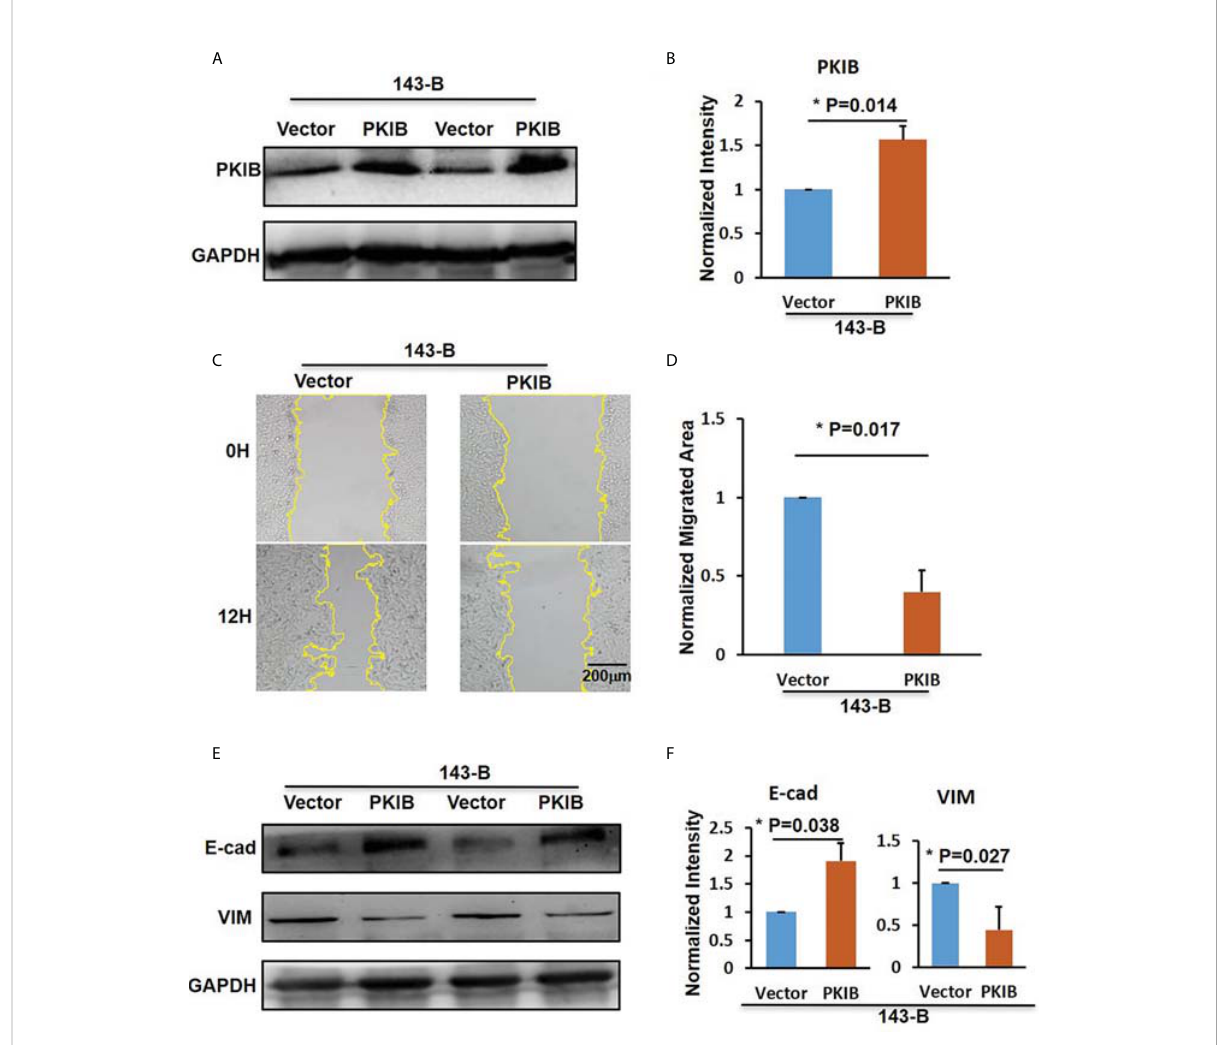
FIGURE 4 PKIB inhibit the migration of osteosarcoma. (A) Representative images of western blot to show the protein expression level of PKIB. (B) Bar graphs showed the normalized intensity of protein expression of PKIB indicated as in panel A. (C) Representative images show the wound- healing detected on time point 0h and 12h in 143-B cells with or without recombinant expression of PKIB. (D) Bar graphs show the normalized migrated area of 143-B cells recombinant express PKIB or not as indicated in panel C. (E) Representative images of western blot to show the protein expression level of E-cad and VIM. (F) Bar graphs showed the normalized intensity of protein expression of E-cad and VIM as indicated in panel E. n>=3, Error bars: Mean±SD,